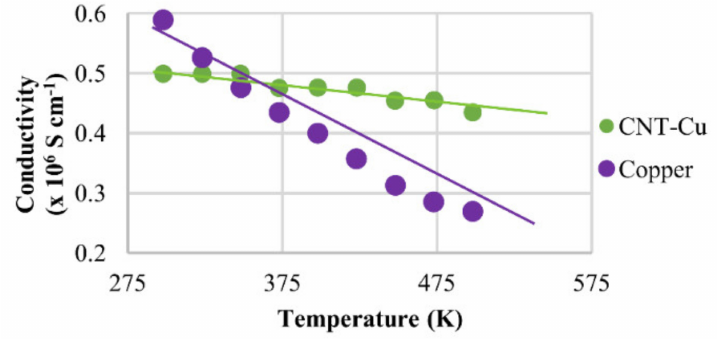
Figure 4. Conductivity variation with temperature in CNT–Cu composite versus pure copper [15].